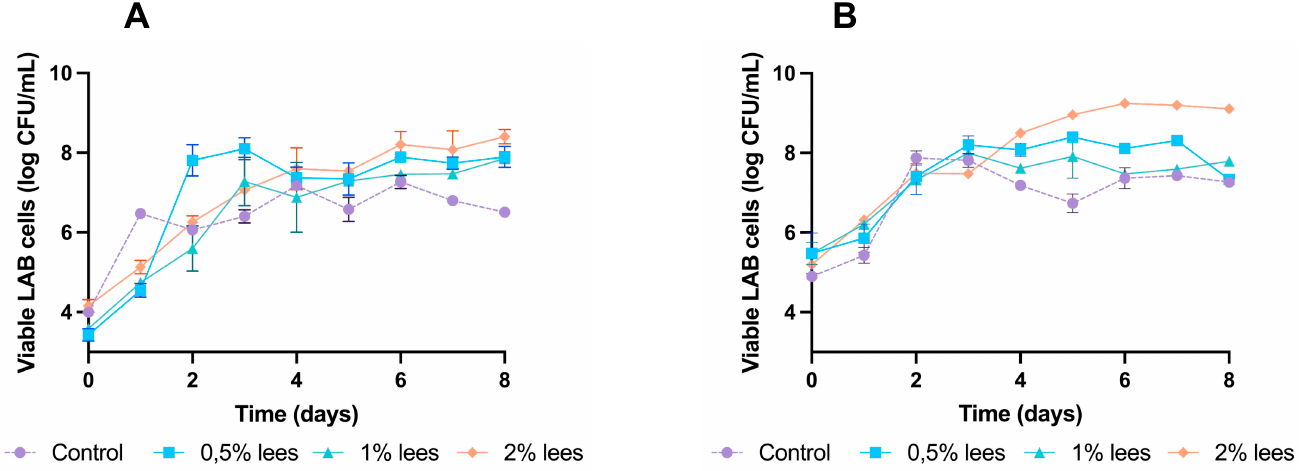
Figure 1. Growth kinetics of LAB during sourdough fermentations: ( A ) wheat sourdoughs; ( B ) rye sourdoughs.